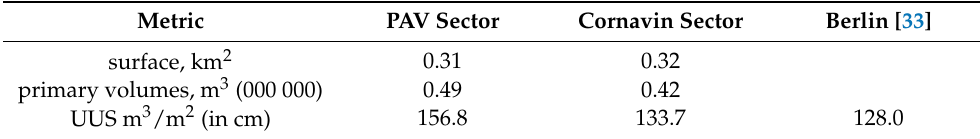
Table 4. Urban underground space (UUS) for PAV (Arve river) and Cornavin zones.